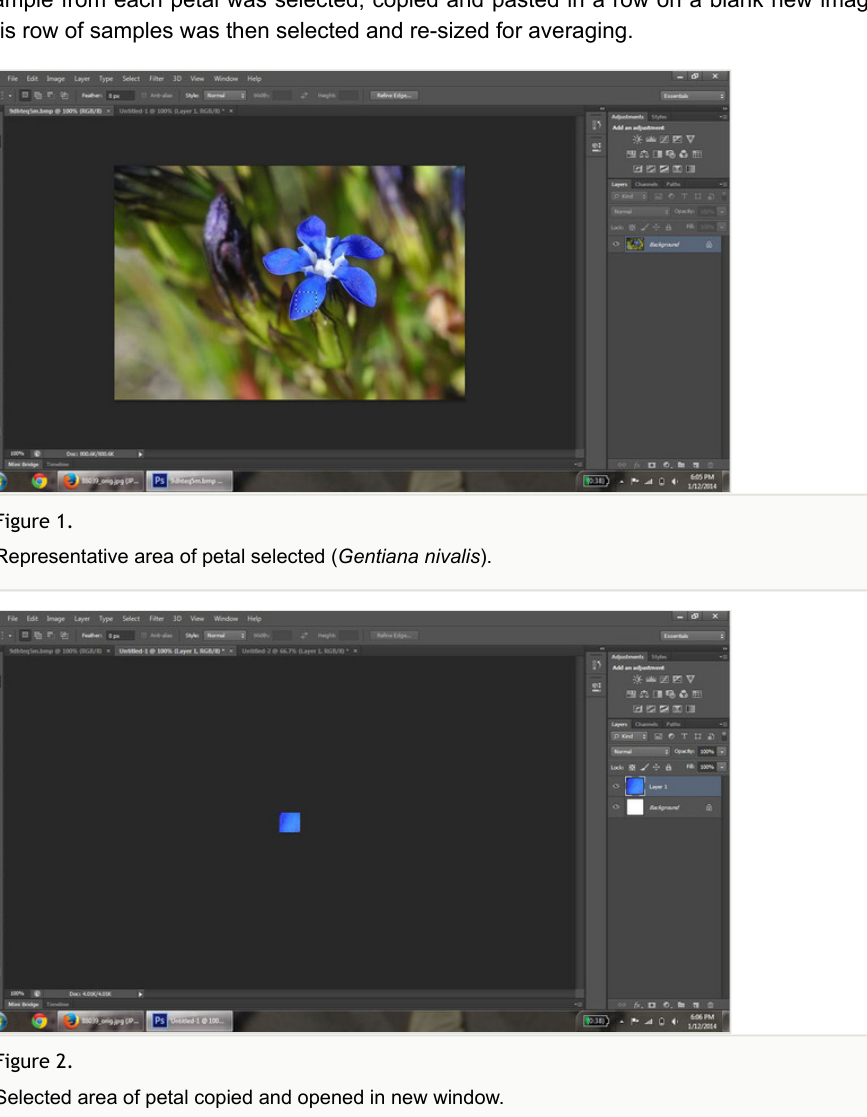
Selected area of petal copied and opened in new